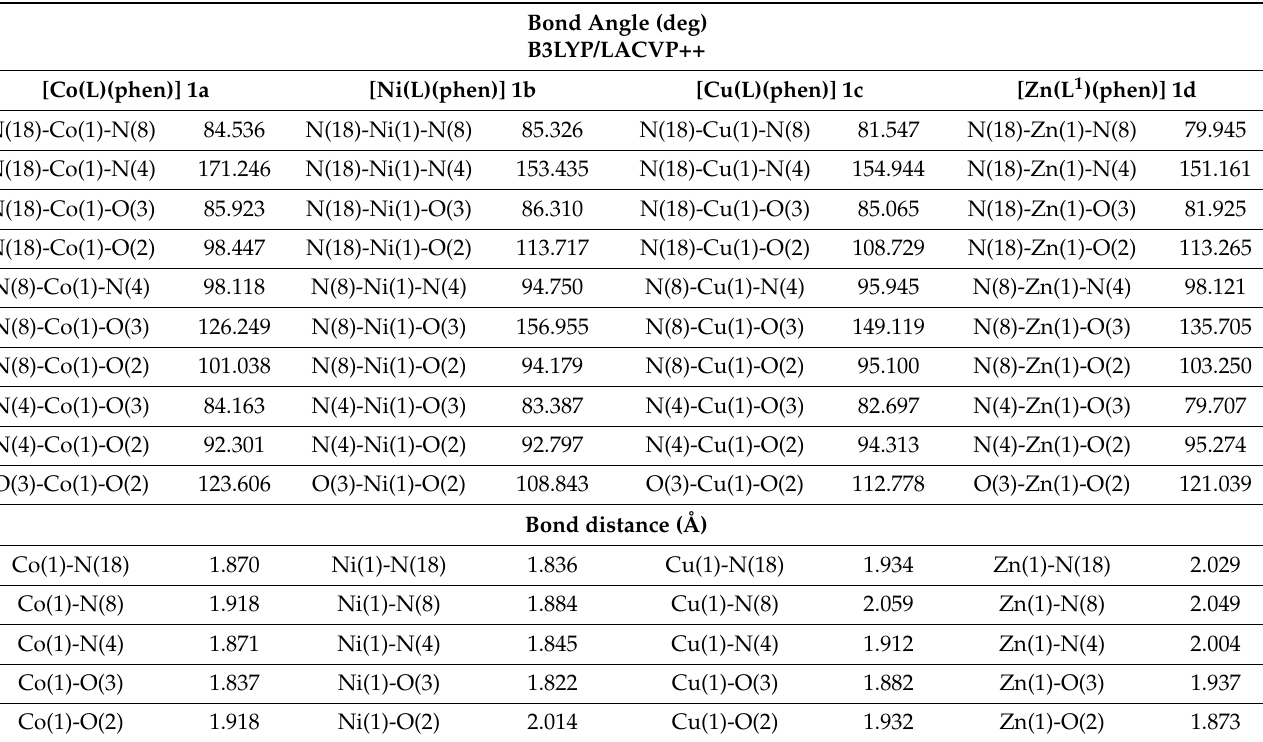
Table 7. Selected optimized geometric parameters of metal(II) complex 1 ( a – d ) determined by B3LYP method using LACVP++ basis set. Bond Angle (deg)